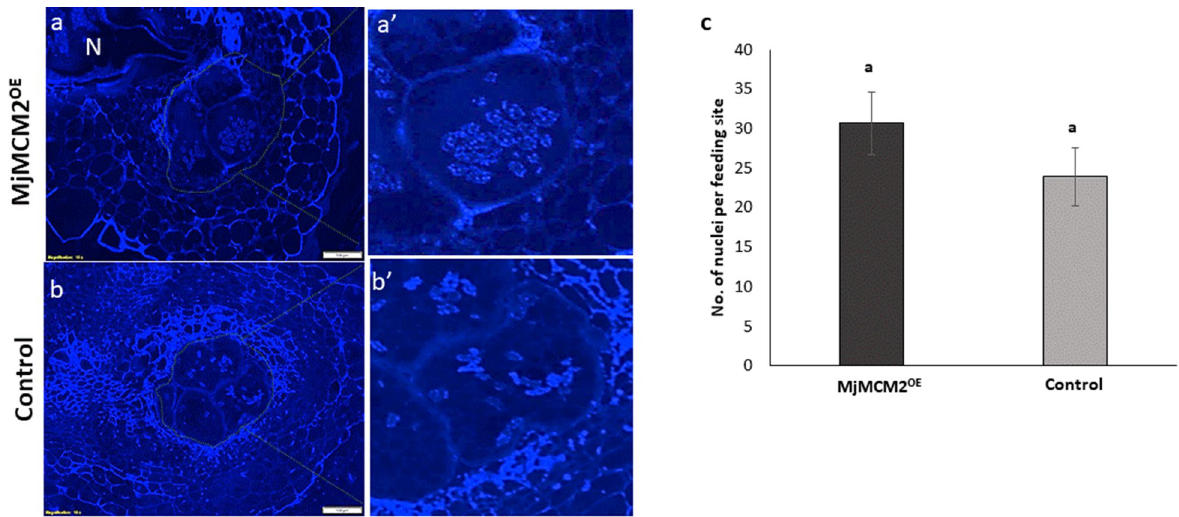
Figure 6. Cytological analyses of galls induced in MjMCM2- overexpressing ( MjMCM2 OE ) lines compared to controls. Sections of galls in tomato hairy roots 28 d after M. javanica infection stained with DAPI. ( a , a’ ) Gall in hairy roots overexpressing MjMCM2 illustrating a higher density of nuclei. Feeding sites are encircled by dots and a giant cell (GC) is zoomed in on in ( a’ ) showing apparently larger nuclei, with prominent chromocenters. ( b , b’ ) Gall from control line (empty vector-transformed roots). Feeding sites are encircled by dots and a GC is zoomed in on in ( b’ ). N, nematode. ( c ) Average number of nuclei per medium-sectioned feeding site of 15 GCs from 15 gall sections of MjMCM2 OE line(dark gray) compared to controls (light gray). Letters above the bars denote significant difference ( P ≤ 0.05, ANOVA) between tomato root lines analyzed by Tukey–Kramer multiple comparison